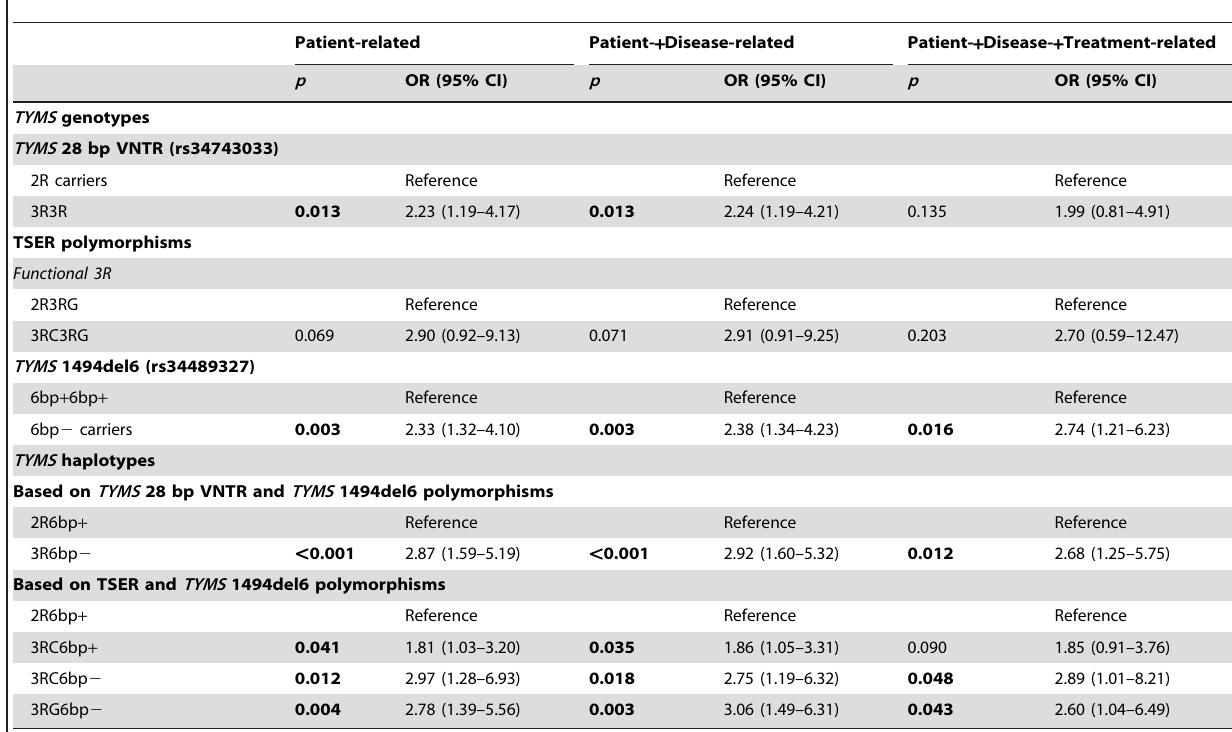
Table 3. Multivariate analysis of thymidylate synthase polymorphisms and clinical response to